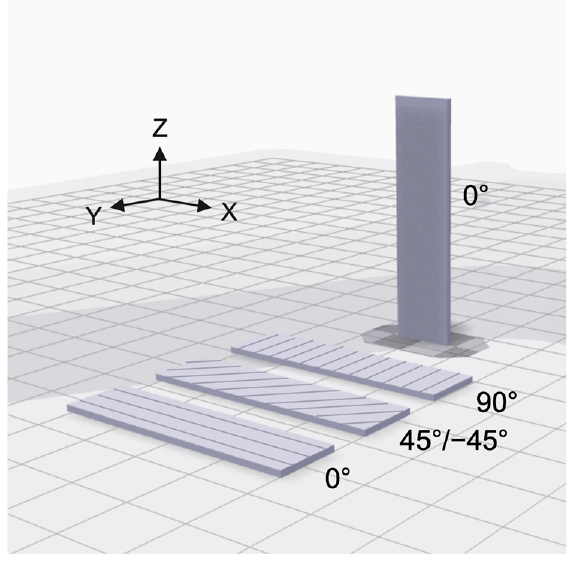
Figure 1. Schematic diagram showing print orientations with respect to the build plate and corre- sponding infill angles for each orientation.